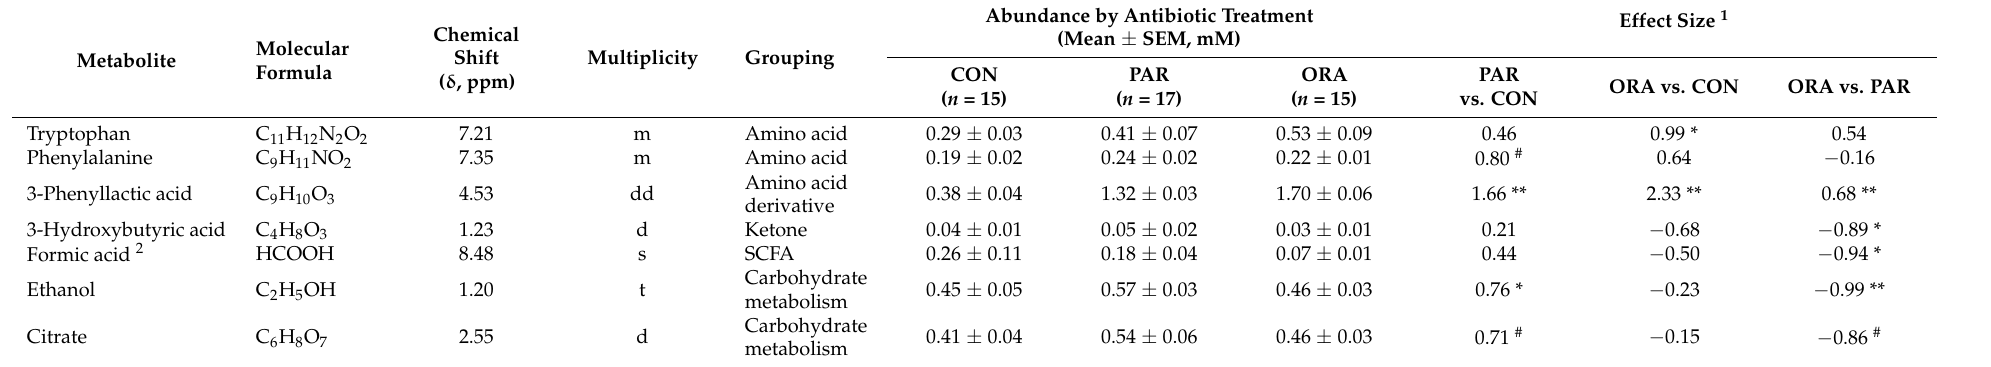
Table 2. Metabolites with differential abundance associated with antibiotic